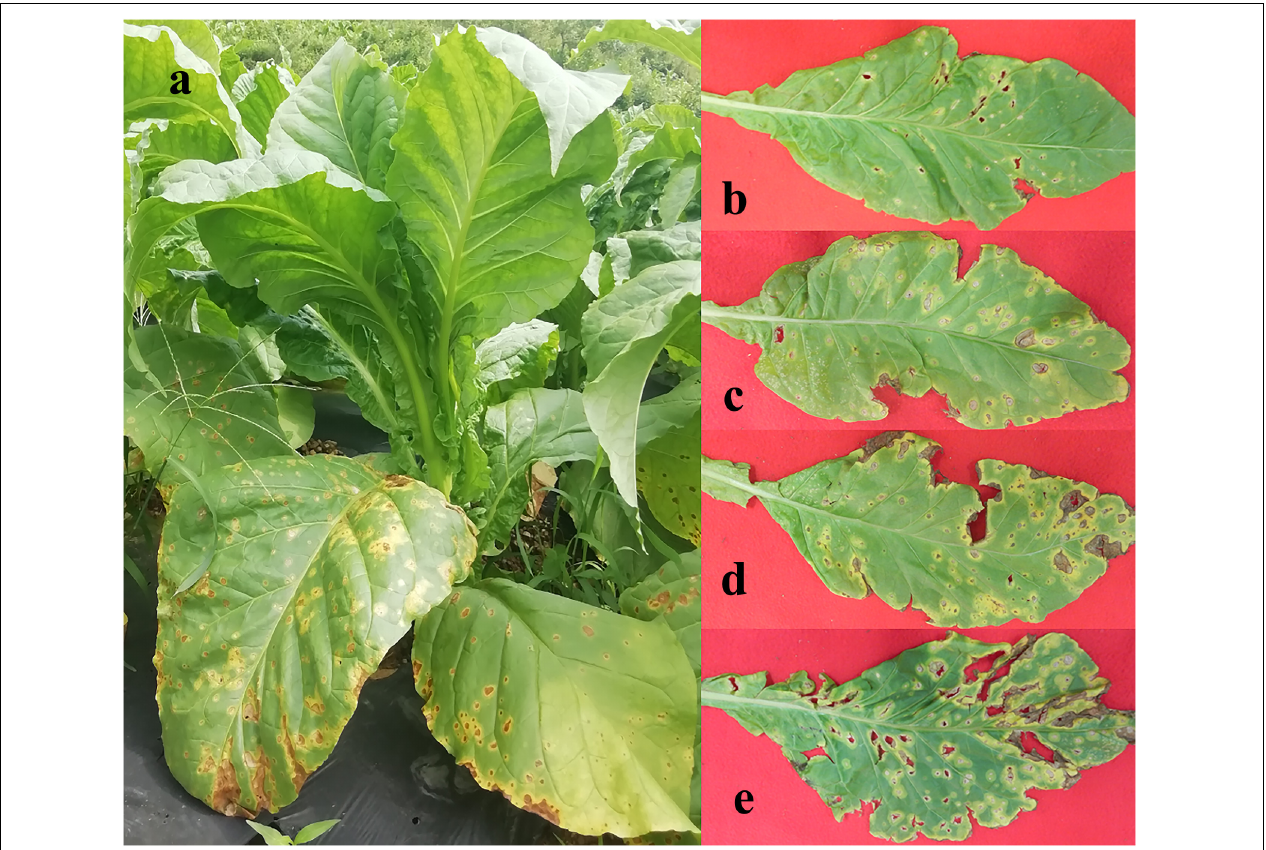
FIGURE 1 | Whole tobacco plant (a) and leaves displaying disease severity at (b) T1G, (c) T2G, (d) T3G, and (e) T4G, respectively. TABLE 1 | Sample information for both diseased and healthy tobacco leaves infected by Didymella segeticola at different disease severity. Disease severity Proportion of lesion area Disease grade Diseased groups (sample) Healthy groups (sample) every leaf Fungi Bacteria Fungi